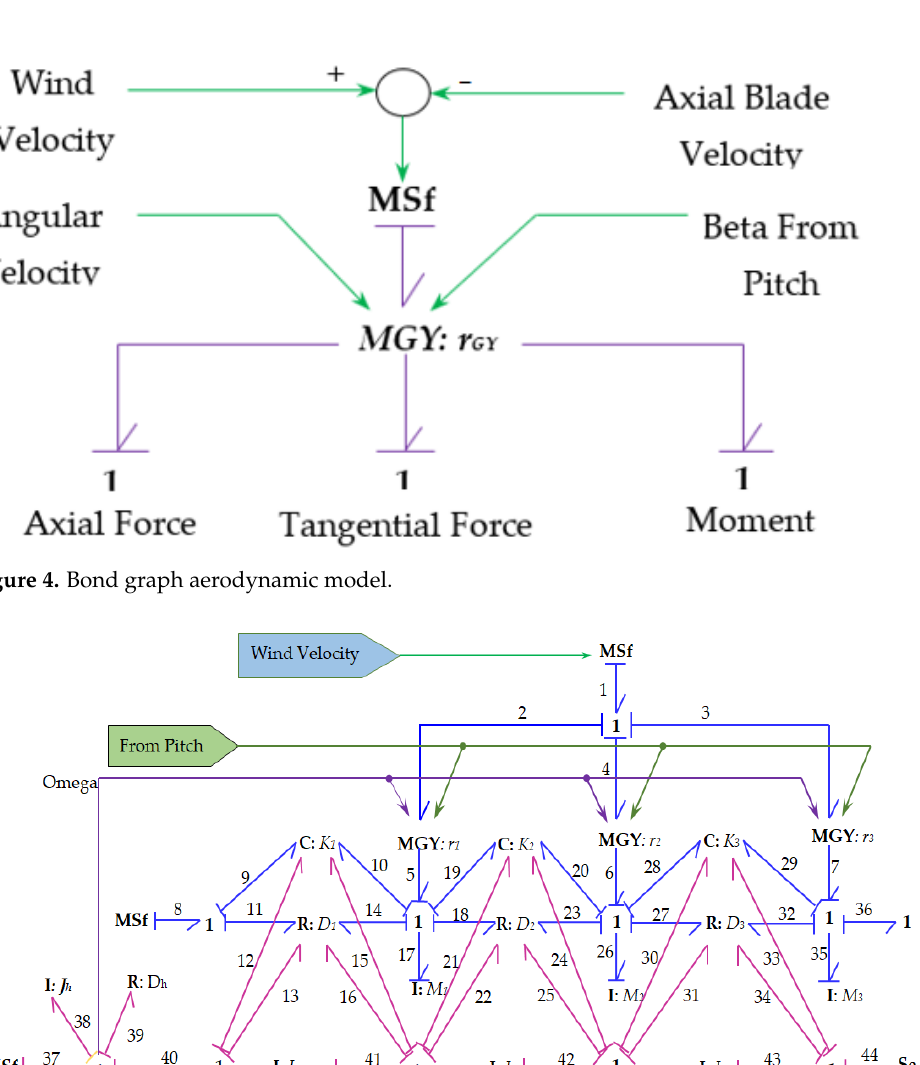
Figure 5. Overall bond graph modeling of wind turbine blade with subjected loads. The bond graph elements are sequentially numbered (1–44).